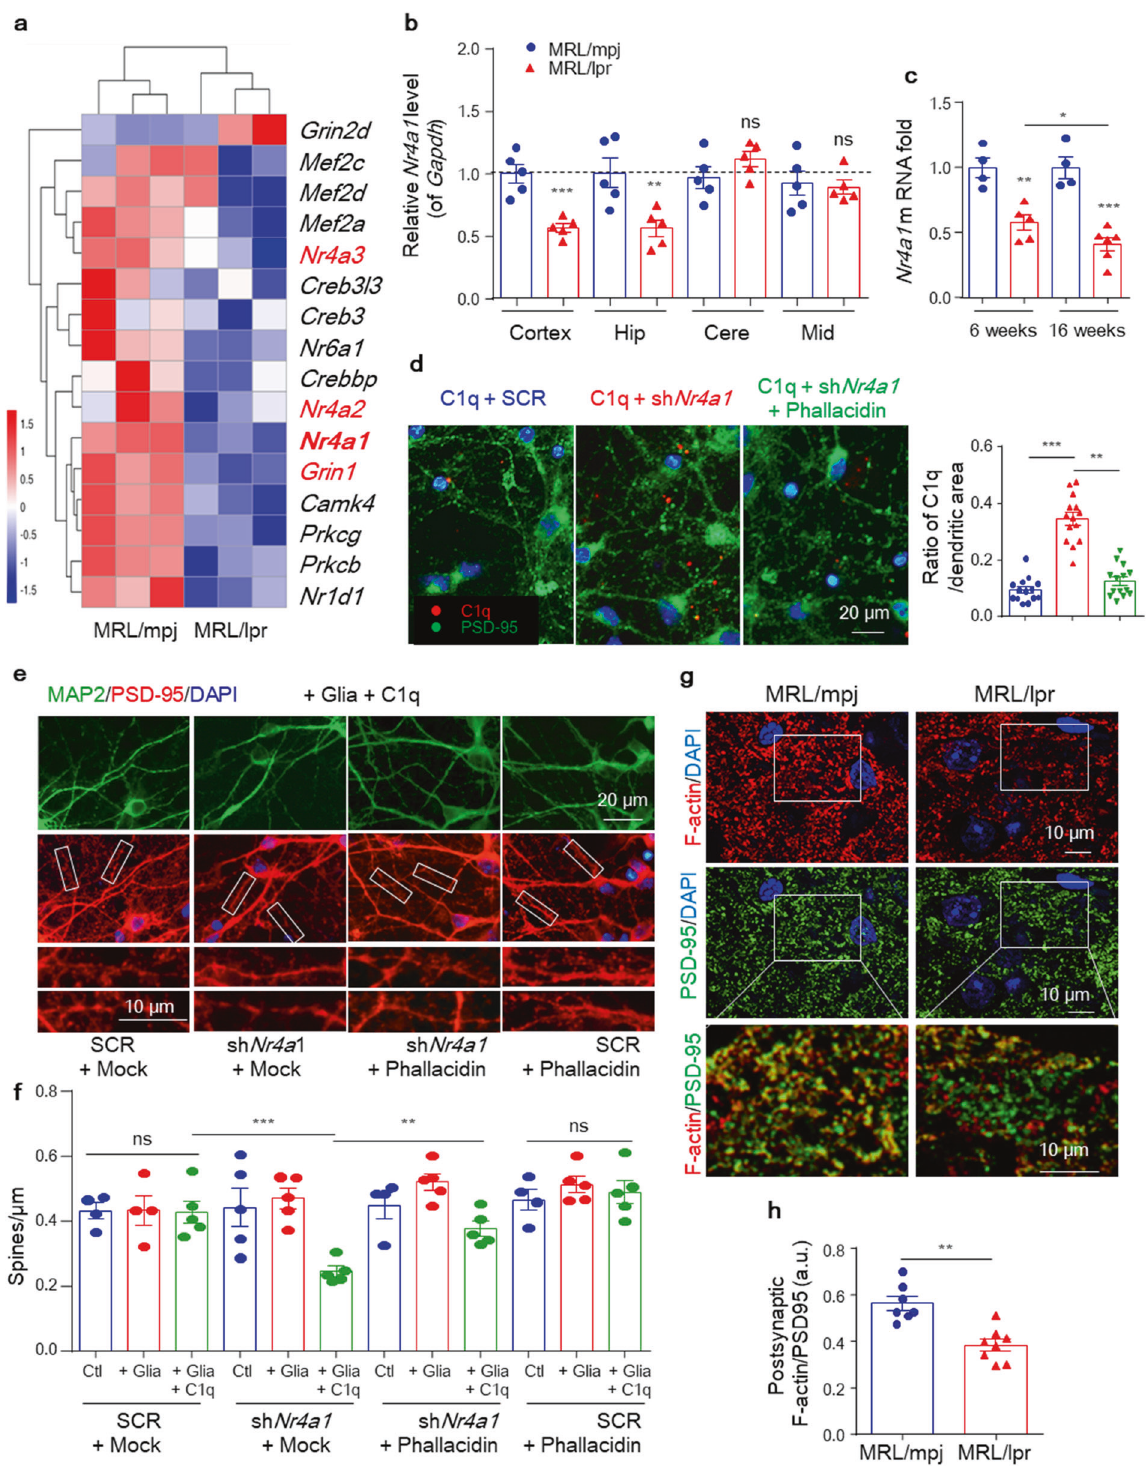
disease. Synapse loss is a hallmark central to many neurode- generative processes, such as aging, AD, and schizophrenia. 14,42 The unbiased identi fi cation of alterations in genes involved in synaptic function, quanti fi ed reductions in synaptic terminals within hippocampal CA1/3, and damaged neuronal circuit observed by electrophysiology provide compelling evidence